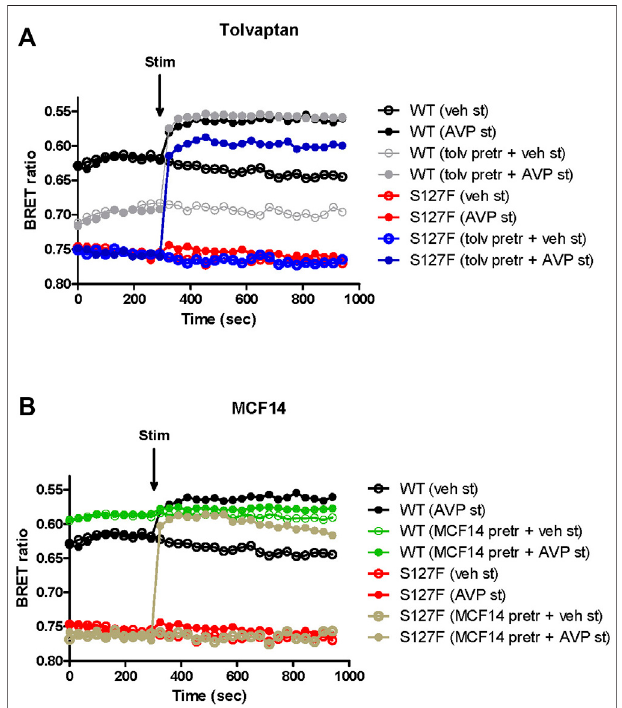
FIGURE 3 | Effects of V2R ligand pretreatment on the cAMP generation of the WT-V2R or S127F-V2R. (A) Effect of tolvaptan or (B) MCF14 pretreatment on the intracellular cAMP production in response to the vehicle or AVP stimulation. HEK293 cells were transiently transfected with the plasmids of the Epac-BRET sensor and either WT-V2R or S127F-V2R. 24 h after the transfection 100 nM tolvaptan or 10 µM MCF14 or vehicle (DMSO) was added to the medium of the cells for 18 hours. Before the BRET measurements of the pharmacochaperone treated cells, the medium of the cells was replaced every 15 min for 1 hour to wash out the remnants of tolvaptanorMCF14.Thecellswereexposedtoeithervehicle(emptycircles)or 1 µM AVP ( fi lled circles) at the indicated time point. The BRET curves are an average of three independent experiments, each performed in triplicates. Mean values are shown but error bars were omitted for better clarity. Since increasing cAMP decreases the BRET ratio, the y axis was inverted to visually represent cAMP level changes.